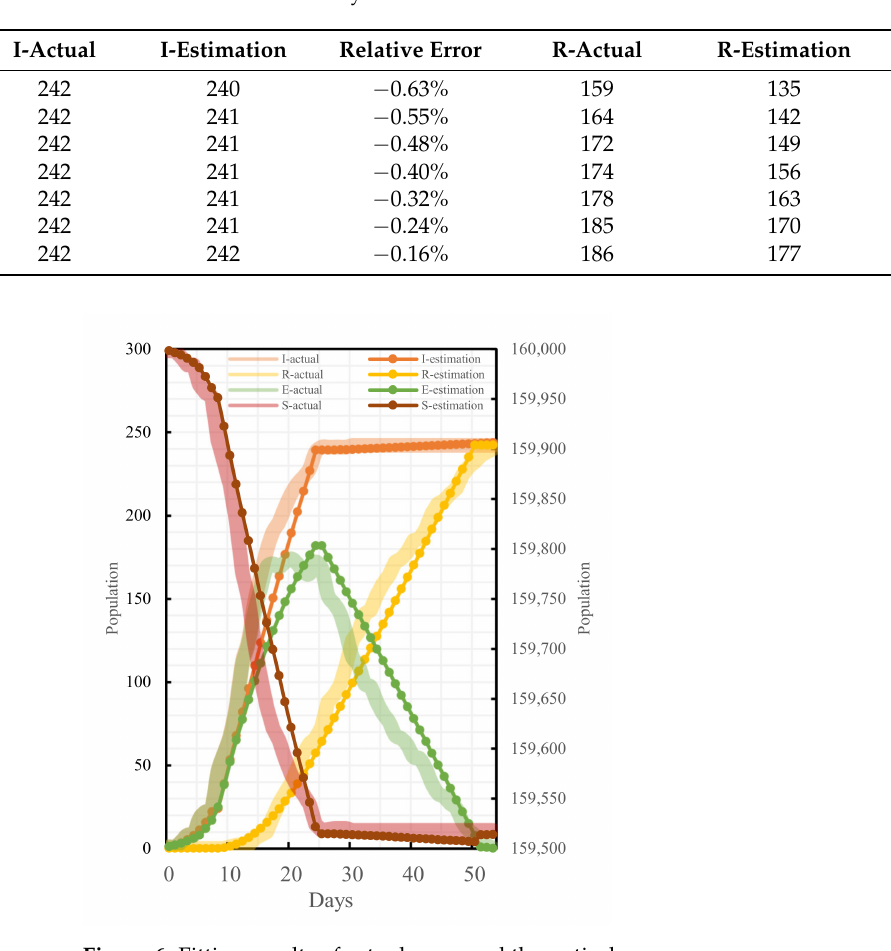
Figure 6. Fitting results of actual cases and theoretical